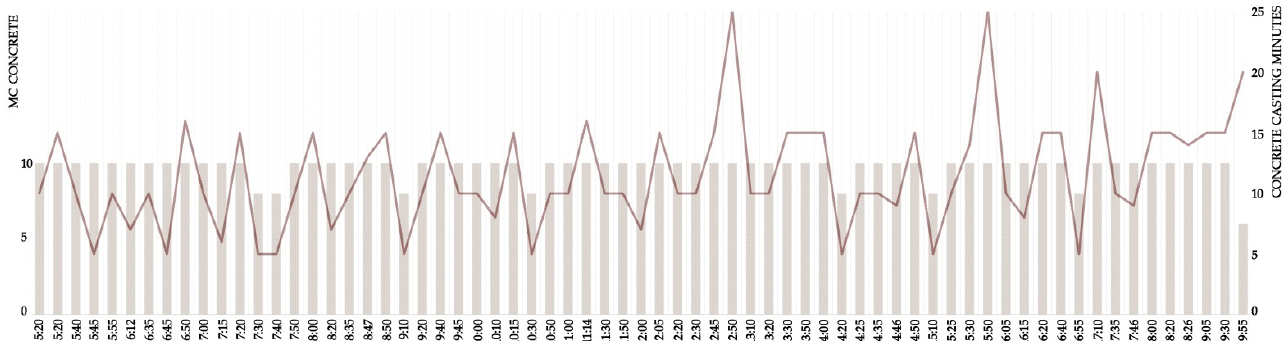
Figure 9. Casting concrete monitoring—Checklist.